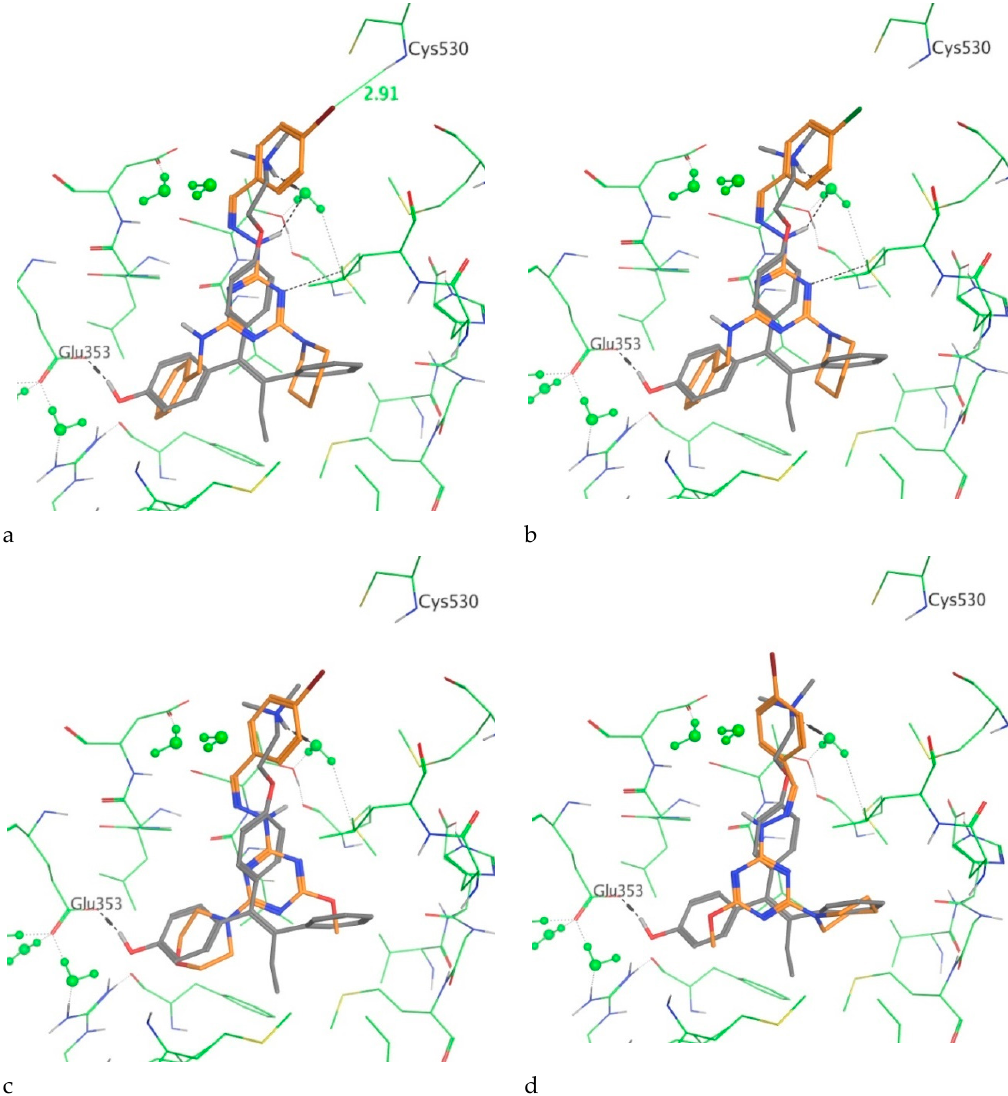
Figure 5. Best ranked docked poses of ( a ) 4c , ( b ) 4b , ( c ) 4l and ( d ) 4f in ER α overlaid on the 4-OHT X-ray structure 3ERT generated with the Molecular Operating Environment (MOE) 2019 software. Carbon atoms are illustrated in grey for 4-OHT, orange for the docked compounds and light green for the protein (oxygen atoms – red; nitrogen – dark blue; sulfur – yellow; bromine – dark red and chlorine – dark green). ER α and associated water molecules are in light green.